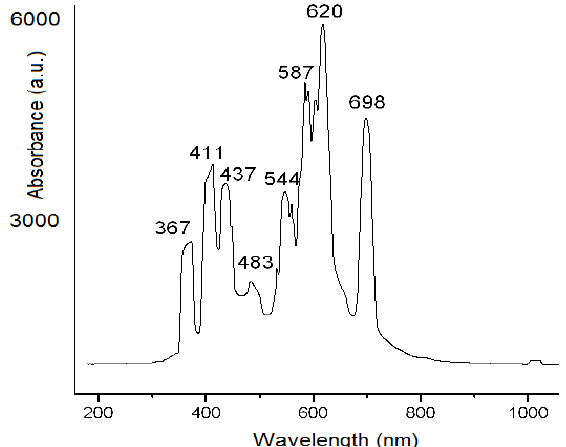
Fig. 1. The emmision spectra of 125 w mercury lamp.